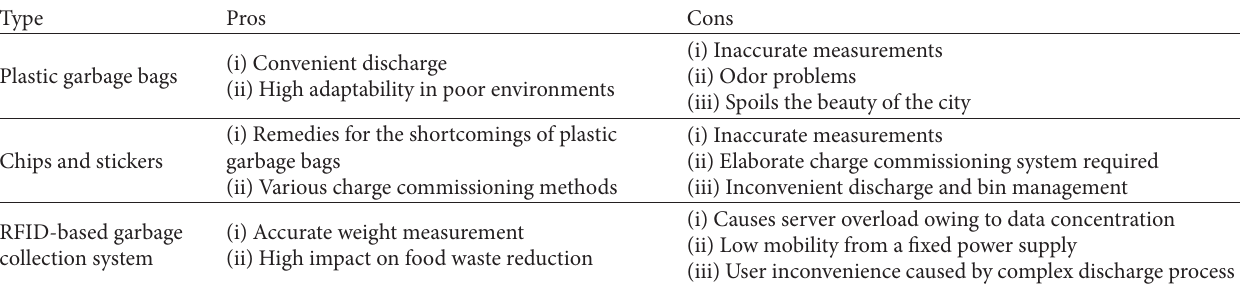
Table 1: Comparison of the three types of volume-rate garbage disposal